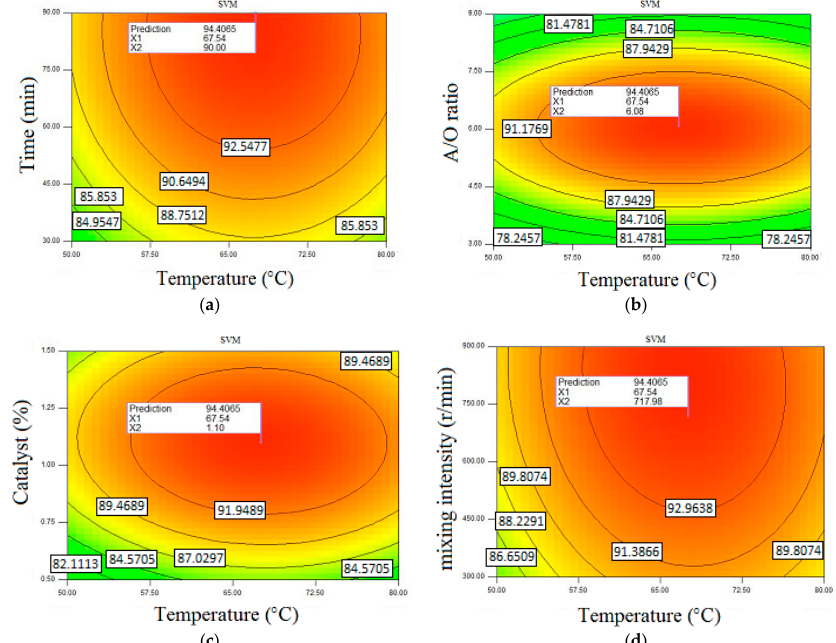
Figure 9. The optimization condition of methyl ester production in the case of using the RSM-SVM method. ( a ) Response surface based on time (min) and temperature (°C); ( b ) response surface based on A/O and temperature (°C); ( c ) response surface based on catalyst (wt. %) ratio and temperature (°C); and ( d ) response surface based on mixing intensity (r/min) and temperature (°C).